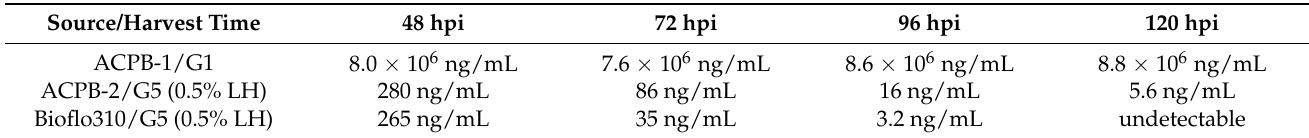
Table 1. Residual BSA of the harvested supernatants at 48, 72, 96, and 120 hpi from the ACPB and NBS-Bioflo310 bioreactors. BSA, bovine serum albumin; hpi, hours post-infection; ACPB, AmProtein Current perfusion bioreactor; NBS-Bioflo310; Bioflo310 from New Brunswick Scientific; LH, lactalbumin hydrolysate.